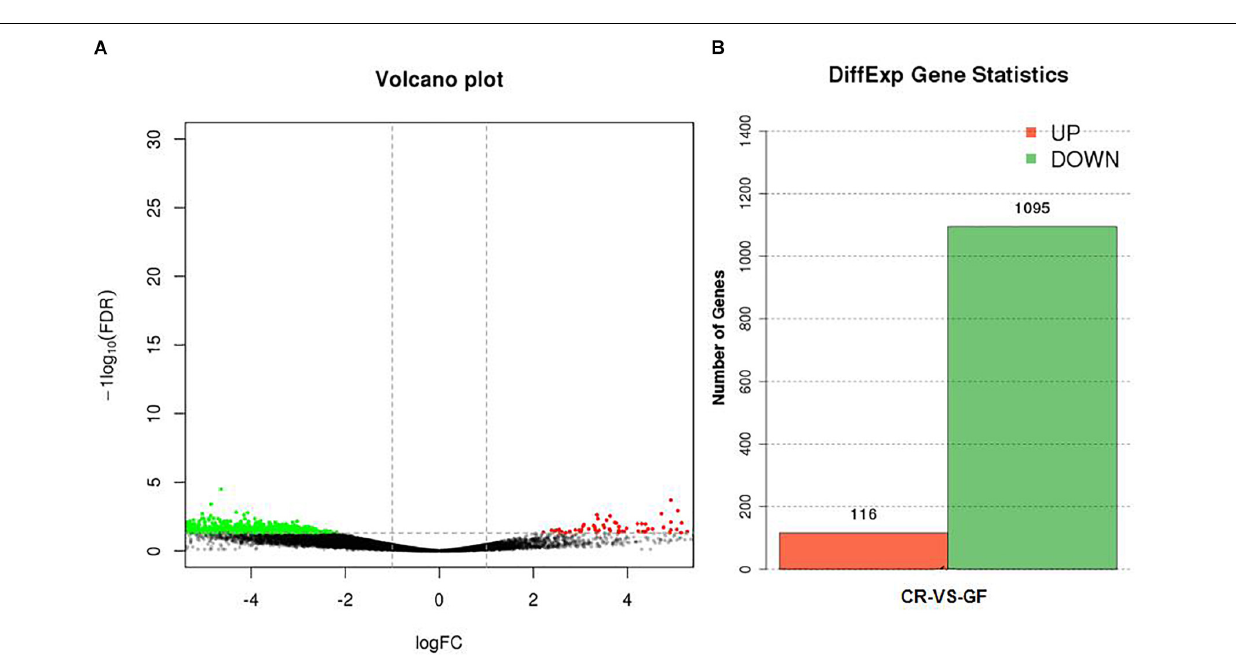
of these unigenes was detected in GF insects, indicating the strong association between gut microbiota and RPW immune system. For instance, a number of immune recognition receptors, including 1 C-type lectin and 1 Galectin unigene, were found